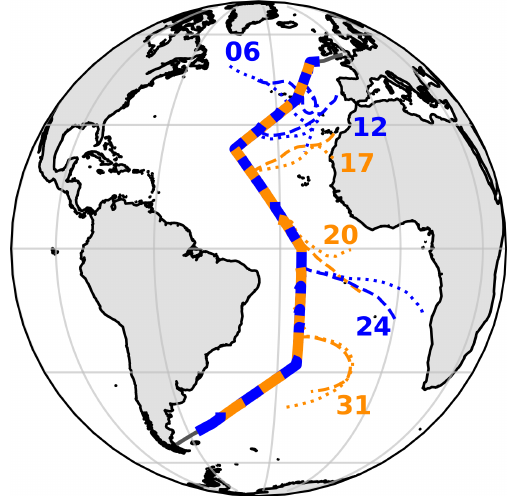
Figure 1. AMT21 cruise track, with aerosol collection periods for each sample shown as alternating blue and orange bars. Five-day air mass back-trajectories for heights of 10 (dashed) and 1000m (dotted) above the ship’s position are shown for samples 06, 12, 17, 20, 24 and 31, representing the RNA, EUR, SAH, SAF, SAB and RSA air mass types respectively (air mass codes are described in the